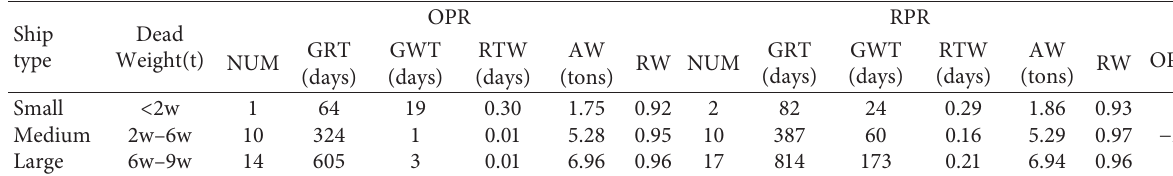
Table 8: Key feature comparison between the optimized and actual plans.